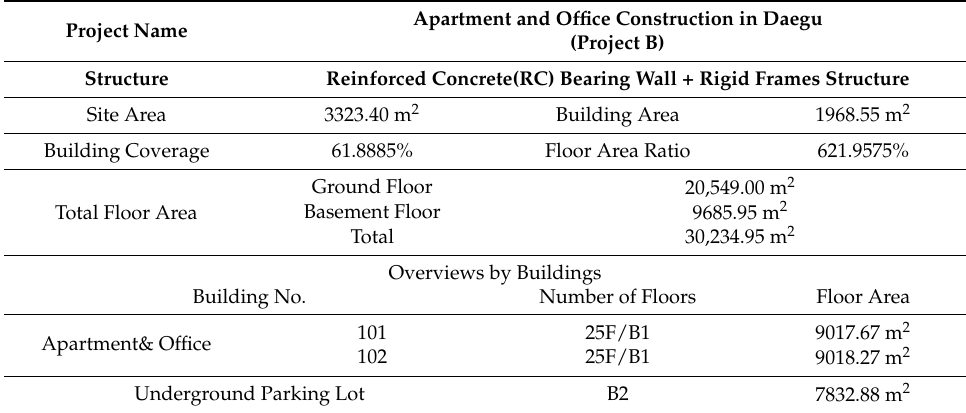
Table A2. Overview of Construction Project B.